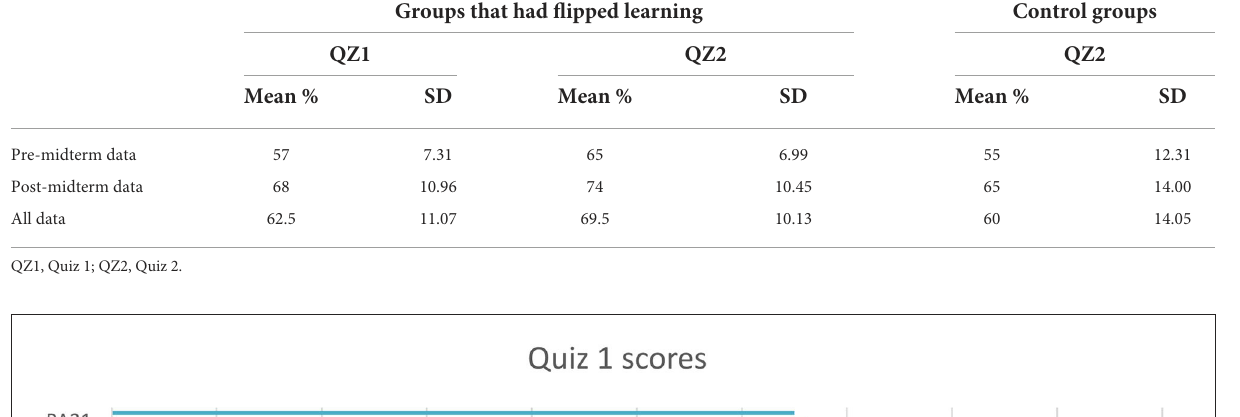
TABLE 3 Score distribution for each quiz in flipped learning and control groups.